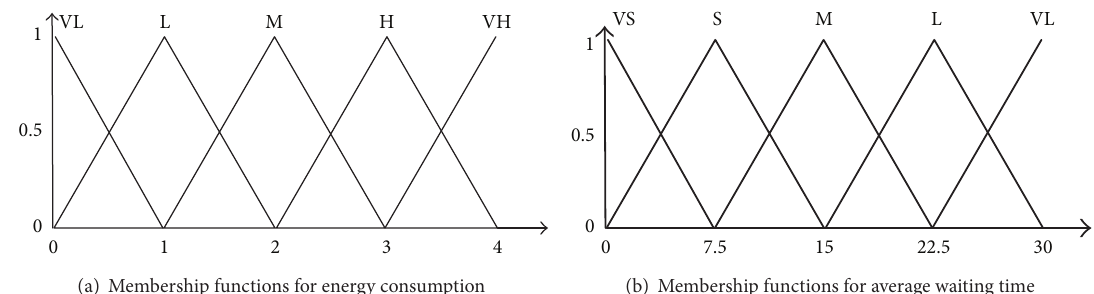
Figure 5: Input membership functions.